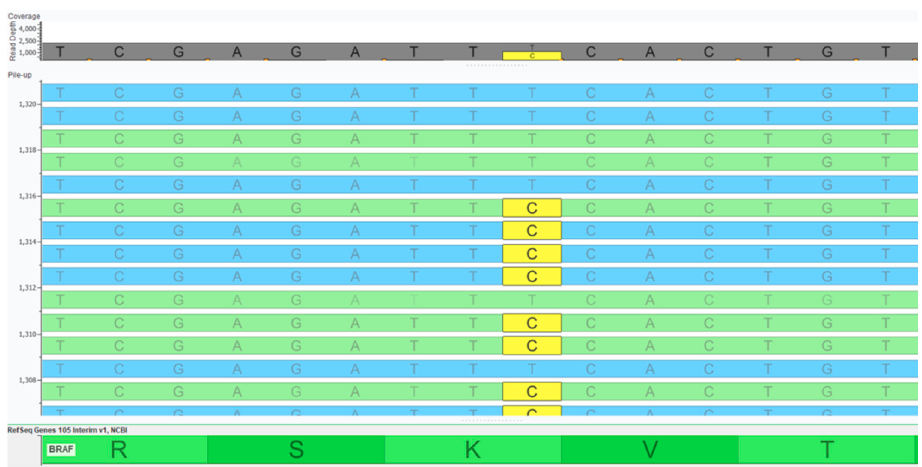
Figure 2. Molecular evaluation. Next generation sequencing analysis revealed the presence of a BRAF exon 15 p.K601E point mutation.